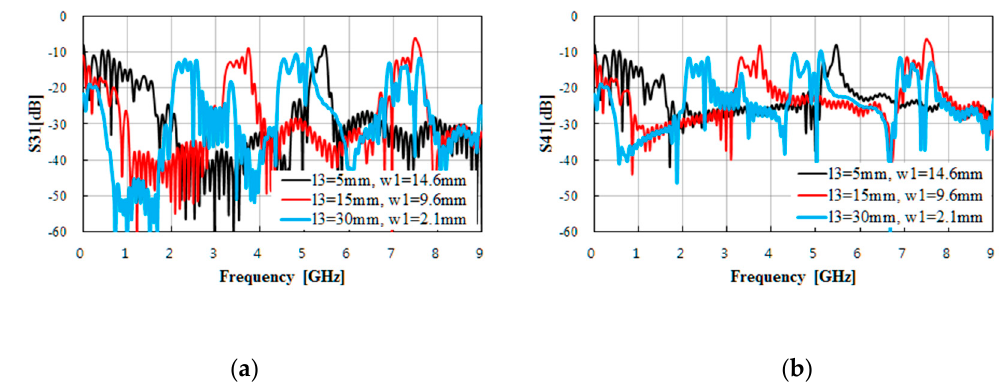
Figure 5. S 31 (near-end crosstalk) and S 41 (far-end crosstalk) of the meander split plane with length l 3 and w 1 changed. ( a ) S 31 ; ( b ) S 41 .